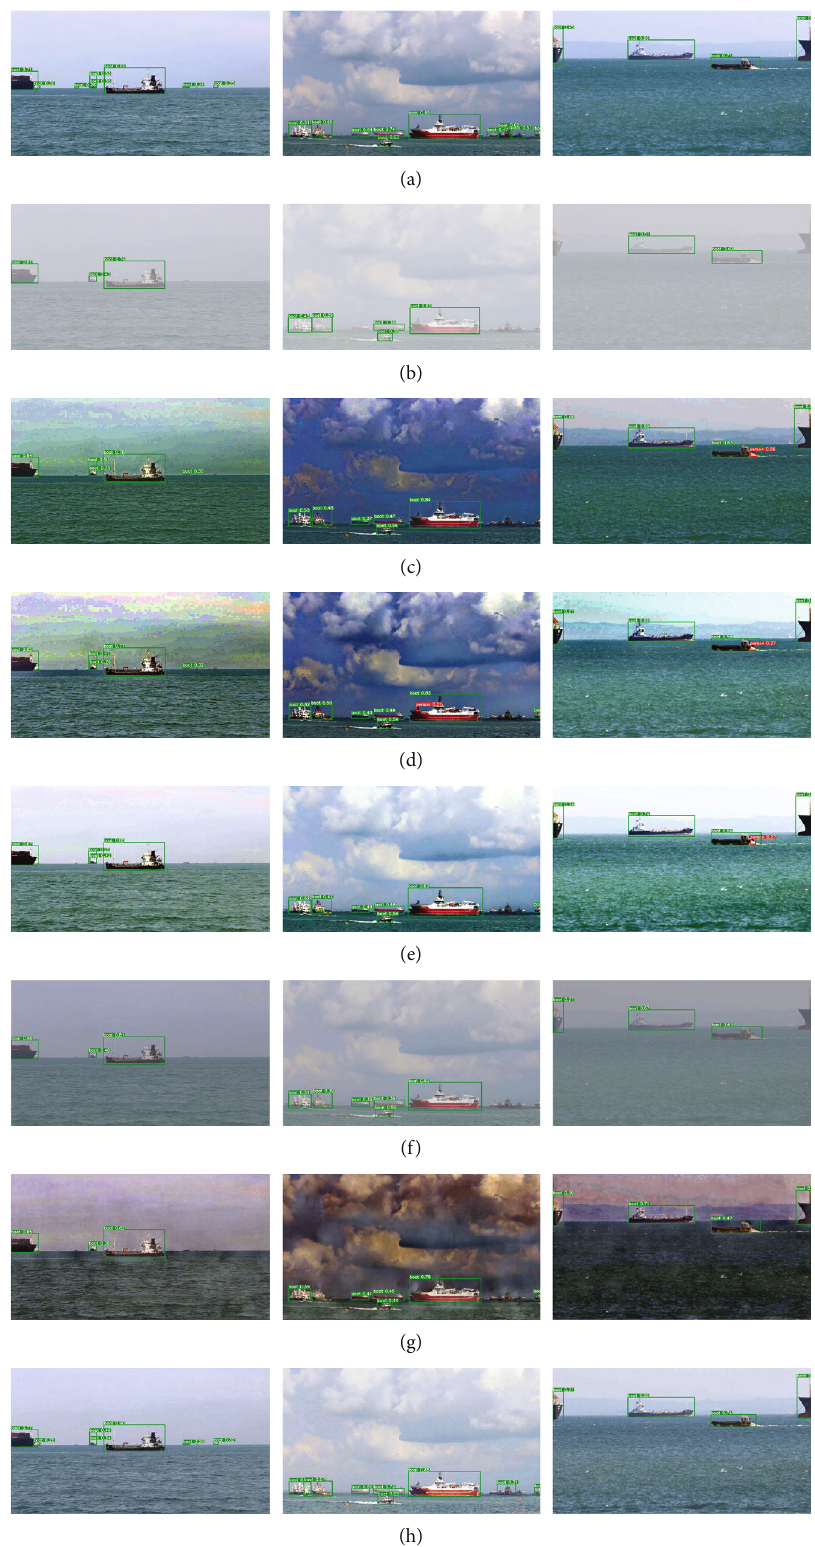
Figure 11: Examples of detection results on the dehazed synthetic hazy images. From top to bottom: (a) clear image, (b) synthetic hazy images, and restored images, generated by (c) DCP [19], (d) nonlocal [37], (e) F-LDCP [20], (f) AODNet [25], (g) GCANet [26], and (h) ours,